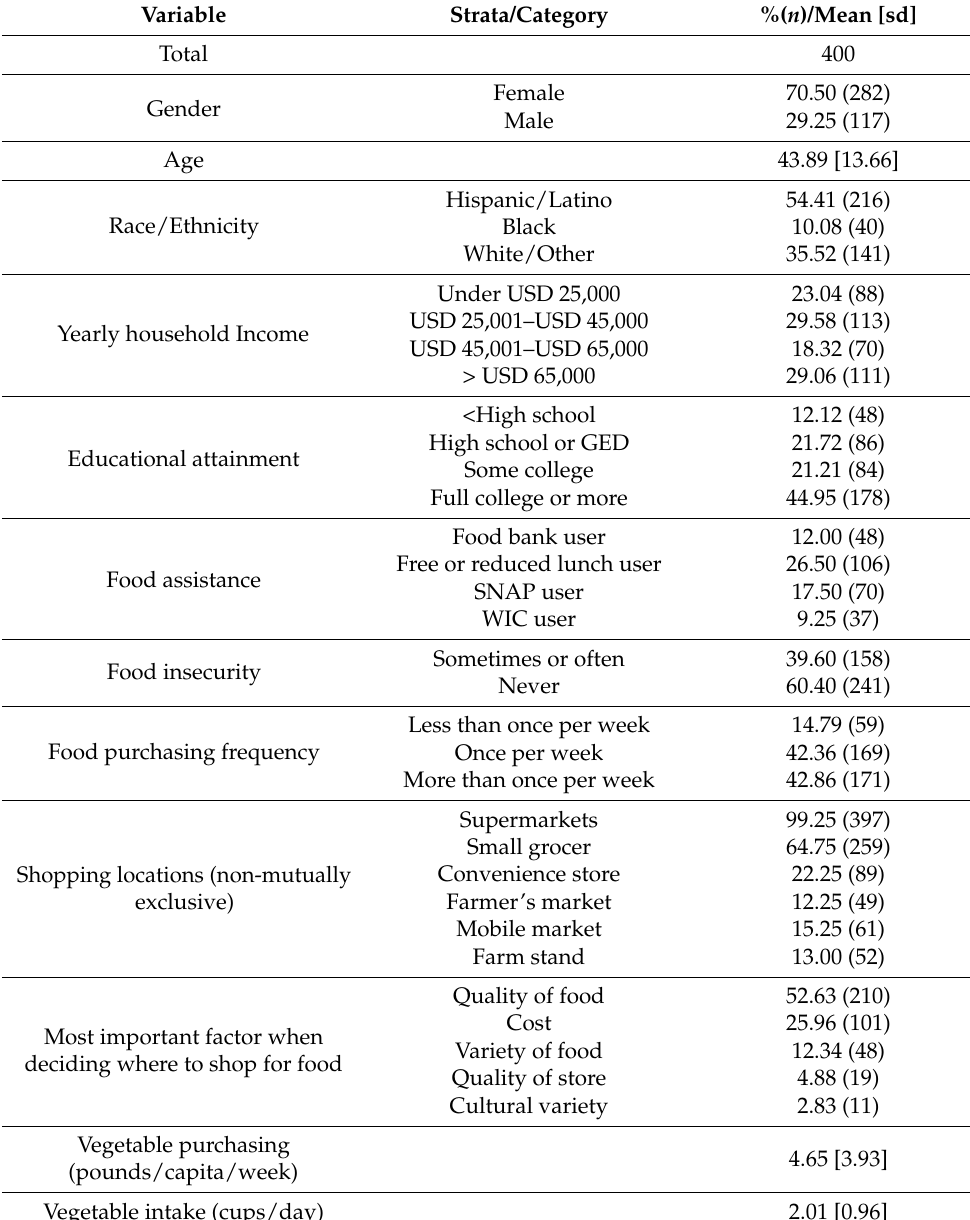
Table 1. Sociodemographic and food-related behavioral characteristics of the FRESH-Austin Study cohort sample, at baseline (2018)